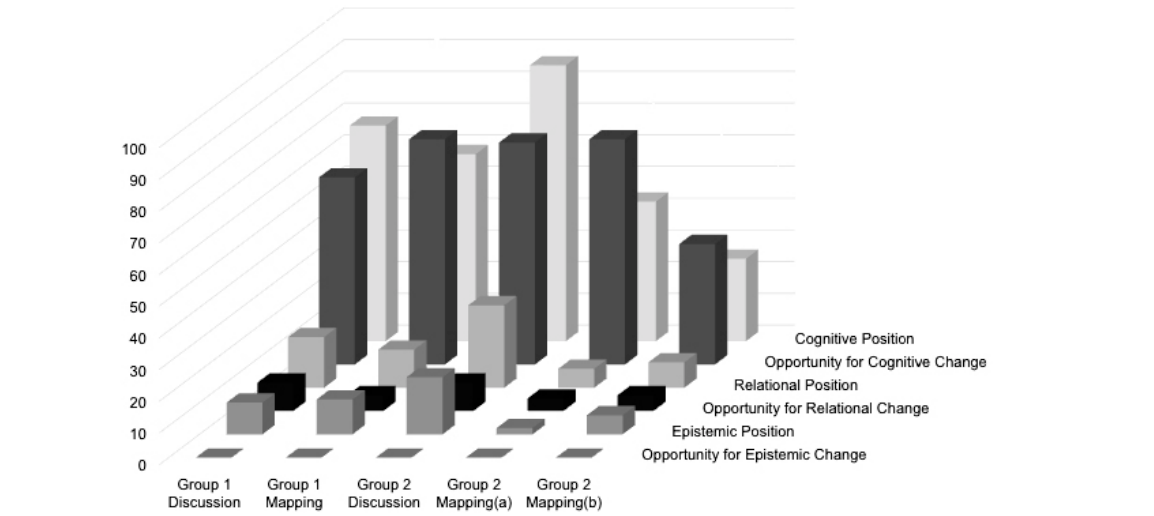
Fig. 3 . The number of stakeholder statements and question-answer exchanges (by coding reference count; Y axis) across all workshop groups and activities (X axis) that demonstrated cognitive, relational, or epistemic positions and opportunities for cognitive, relational, and epistemic changes in understanding (Z axis). No opportunities for epistemic change in understanding were